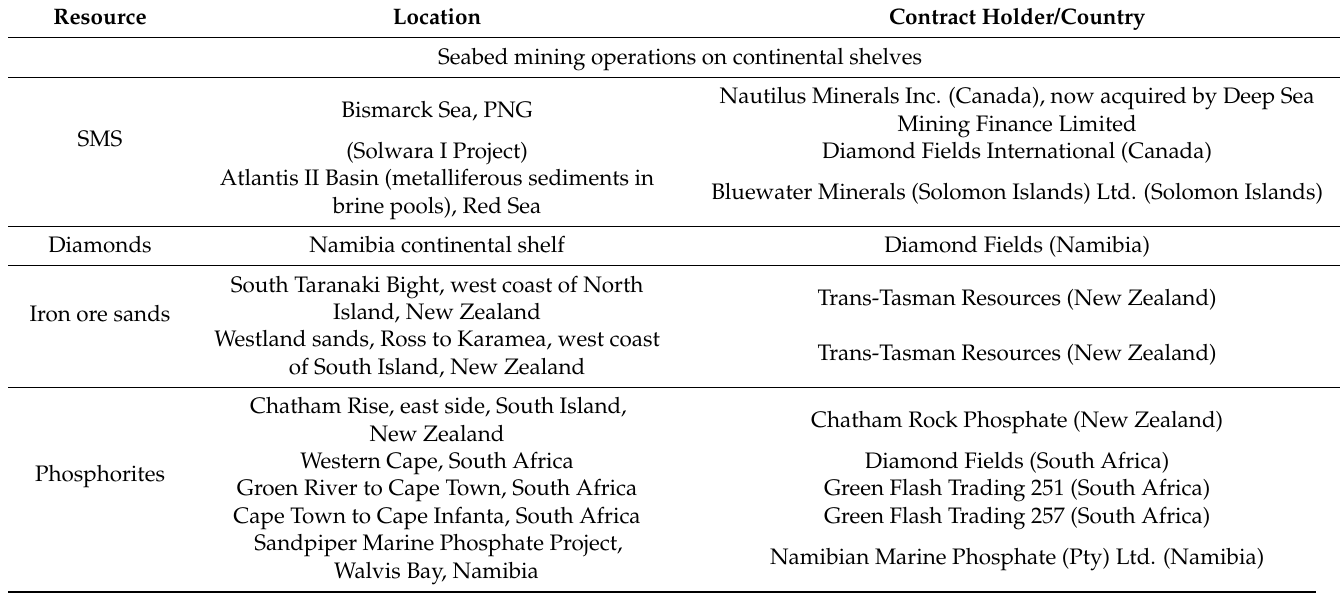
Table 1. DSM operations on Continental Shelves and “the area”